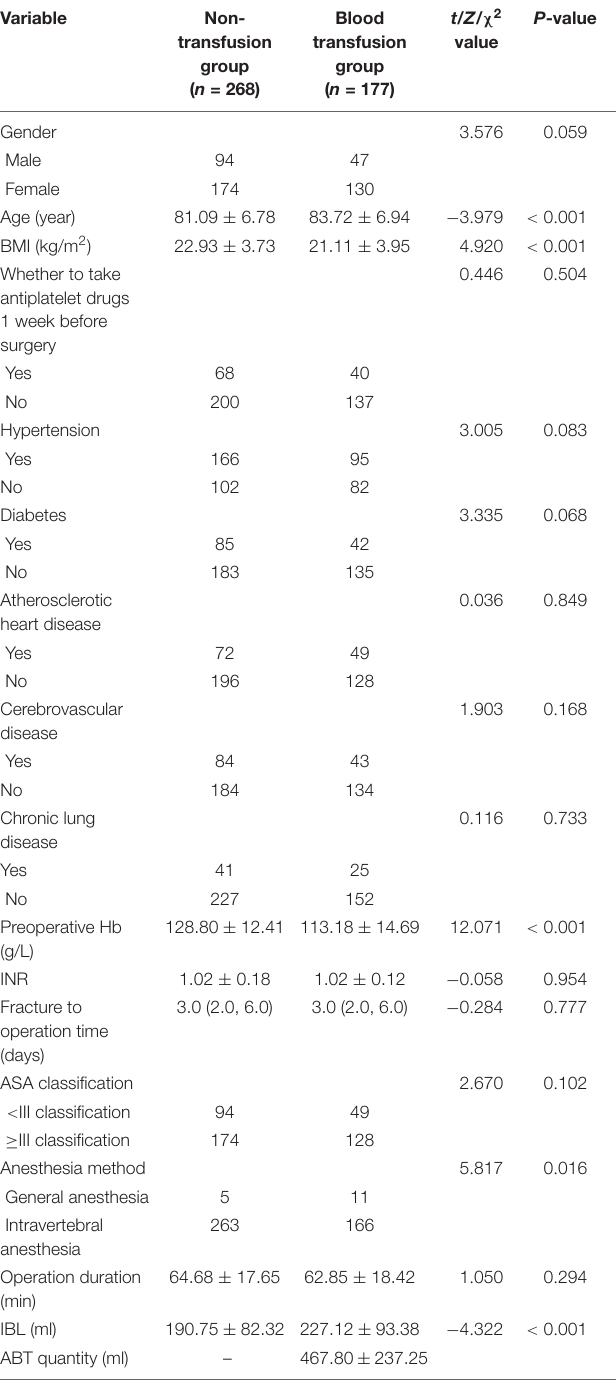
TABLE 1 | Univariate analysis of ABT after HA in elderly patients with FNF. Variable